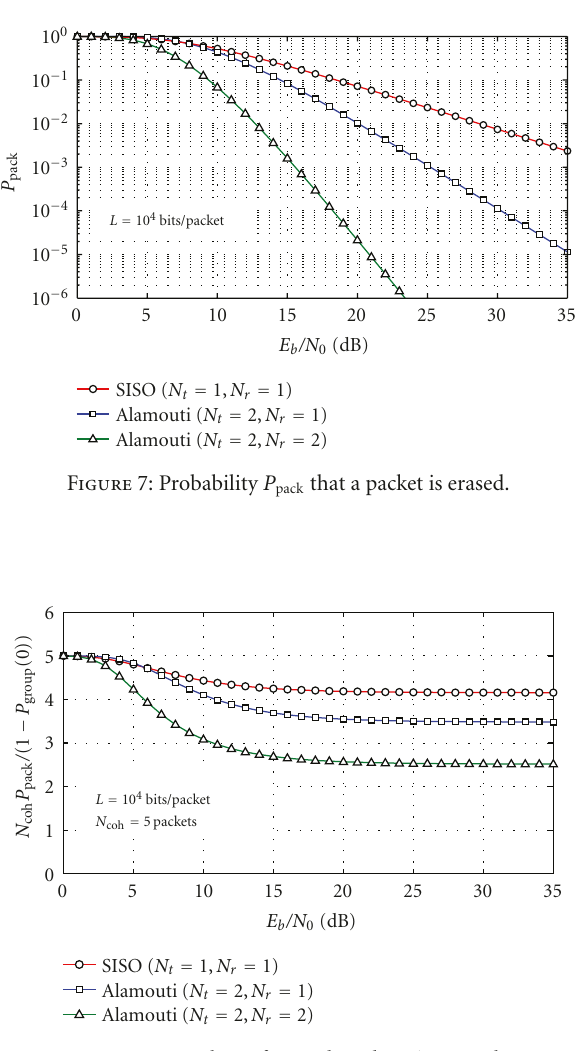
Figure 8: Average number of erased packets in a packet group, conditioned on the event that at least one packet in the packet group is erased.